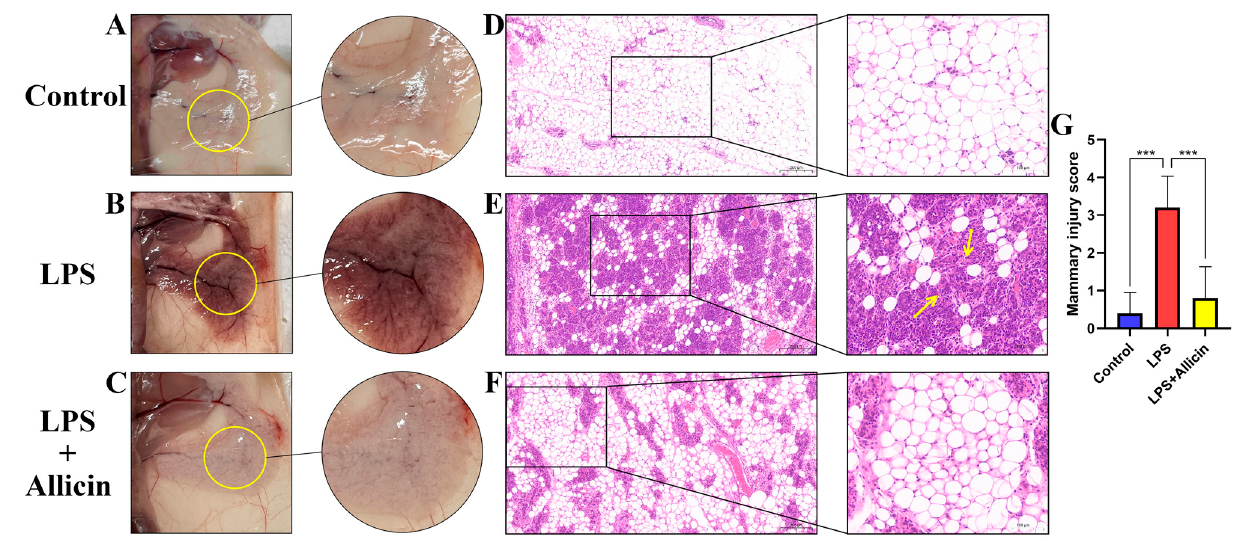
Figure 5. Effect of allicin on LPS-induced mammary gland injury. Histopathological changes in mammary tissue (H&E staining). ( A – C ) Photographs showing the morphology of mammary tissue in mice. ( D – F ) H&E staining of mouse mammary gland paraffin sections: yellow arrows indicate inflammatory cell infiltration in the mammary tissue. ( G ) Pathological damage scores for mouse mammary gland tissue. ***, p <